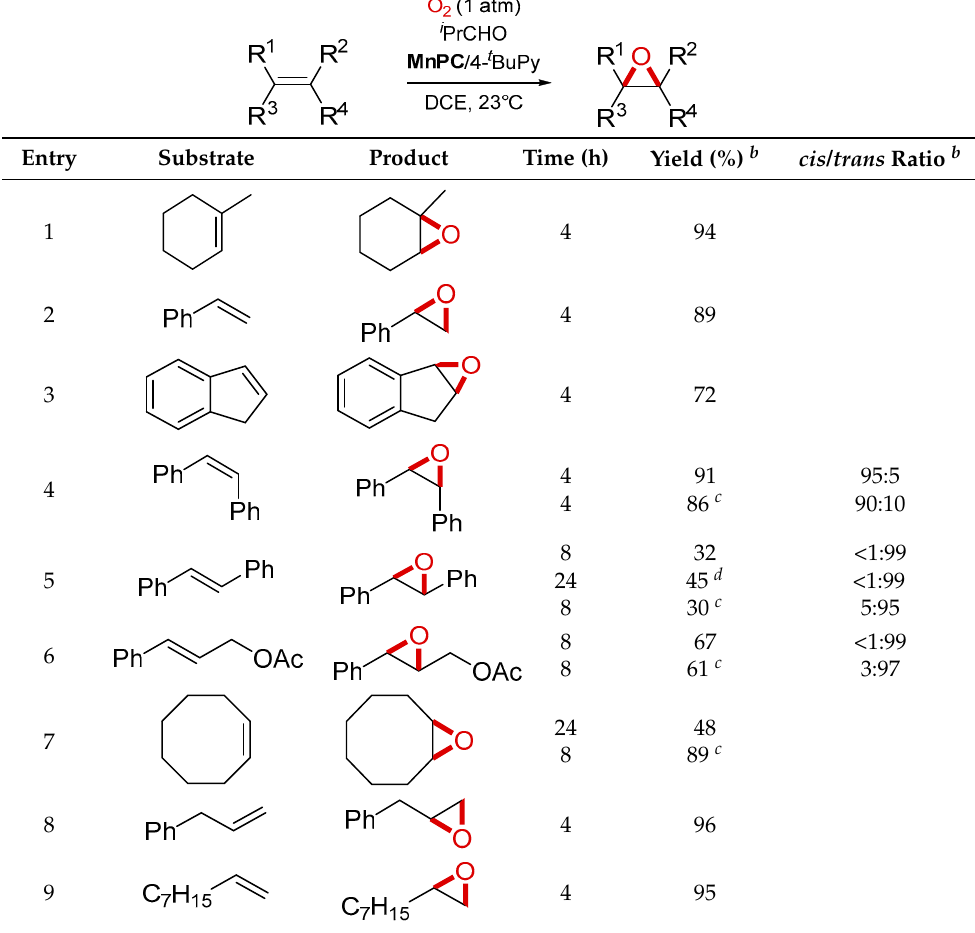
Table 2. Scope of the aerobic epoxidation of olefins catalyzed by manganese porphyrin catalyst MnPC. a Entry Substrate Product Time (h) Yield (%) b cis / trans Ratio b